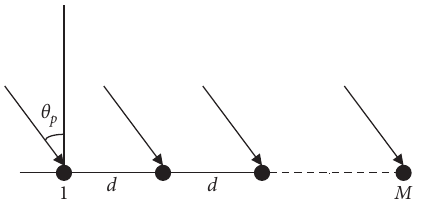
Figure 1: Signal arrival to uniform linear